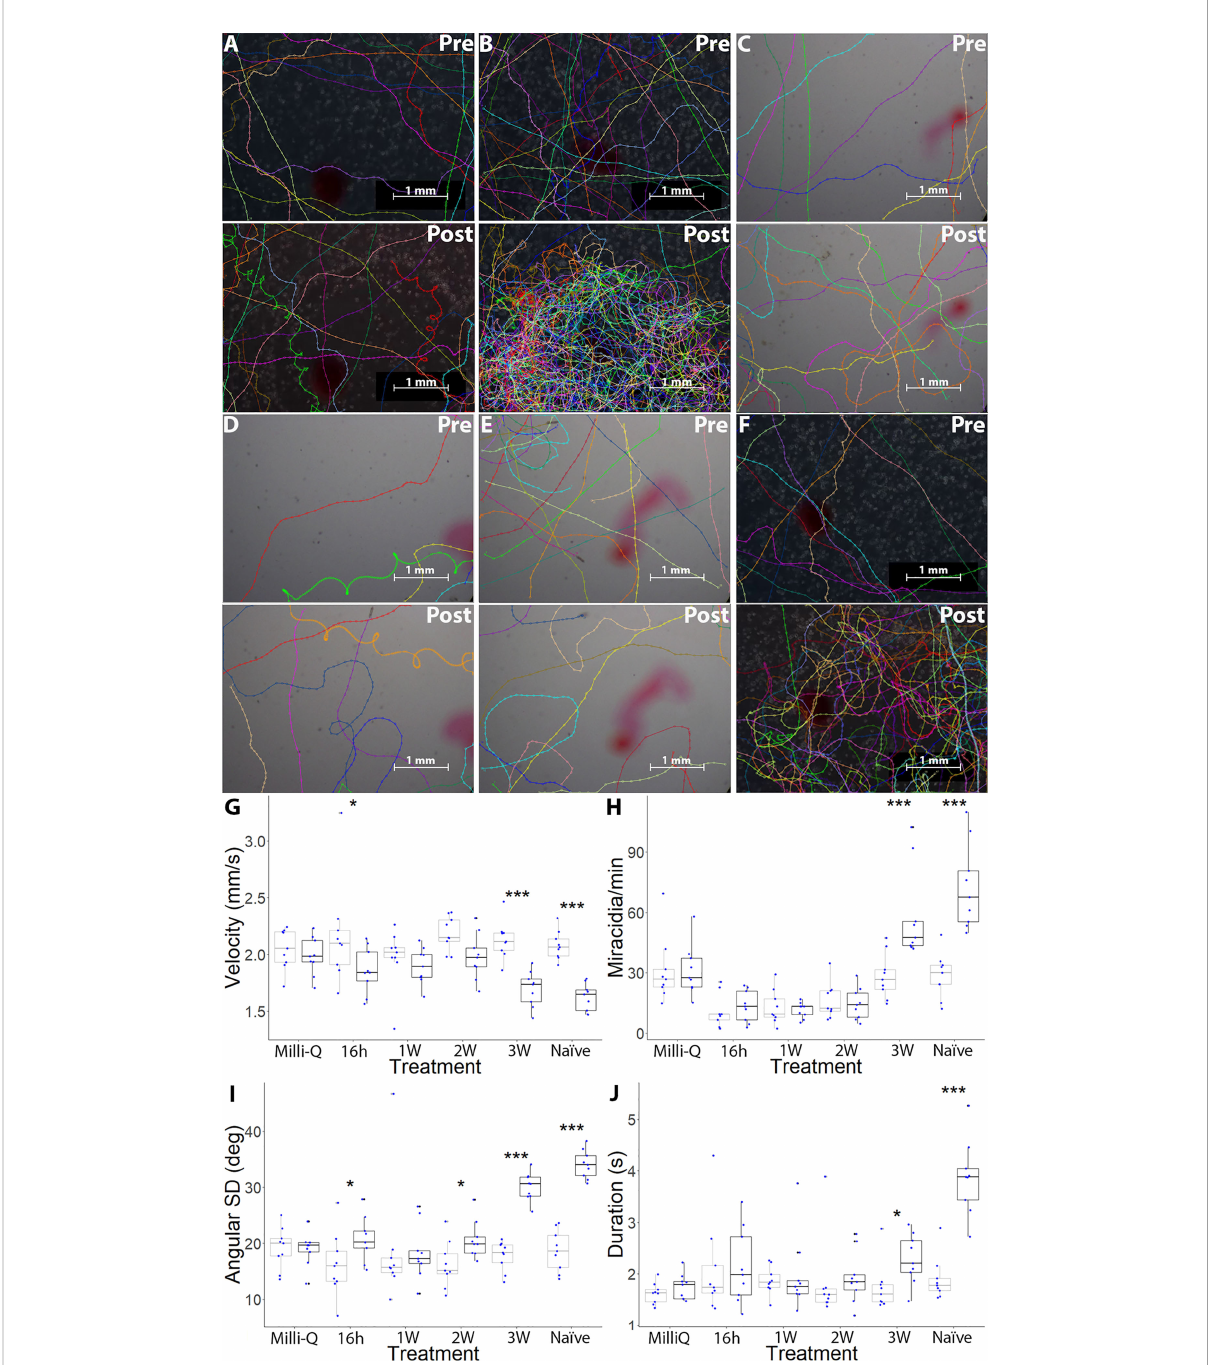
FIGURE 1 Changes in S. mansoni miracidia behaviour from 1 min pre-addition and post-addition of pH-neutral Milli-Q water, 16h-PME, 1W-PME, 2W-PME, 3W-PME and naïve SCW. A representation of miracidia tracks, generated in TrackMate and manually corrected, pre-addition and post-addition of 2 m L of (A) Milli-Q water, (B) naïve SCW, (C) 16h-PME SCW, (D) 1W-PME SCW, (E) 2W-PME SCW and (F) 3W-PME SCW (24). See Video S1-S6 for representative videos. Scale bars are in the bottom right-hand corner of every representative image. Boxplot indicates median, 25 th and 75 th percentiles, minima and maxima. (G) Mean velocity (mm/s); (H) average track per min; (I) angular SD (degrees) and (J) average duration of presence (s). Blue dots indicate the data attained from nine individual replicates of data from each treatment. Points beyond 1.5× the interquartile range either below the lower quartile or above the upper quartile are indicated as outliers. A two-way ANOVA test was used to calculate P -values for the mixed- effects interaction of pre-addition and post-addition SCW treatments against Milli-Q water: * P < 0.05, ** P <0.01, *** P <0.001. Colour: Grey: Pre-addition; Black: